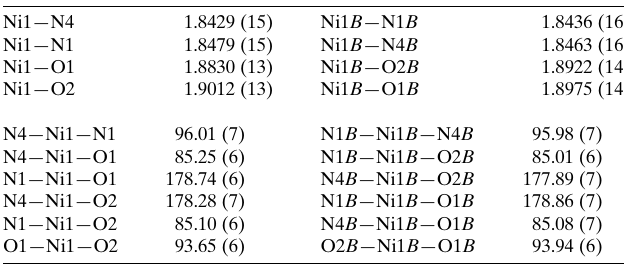
Table 1 Selected geometric parameters (A˚ , (cid:4)